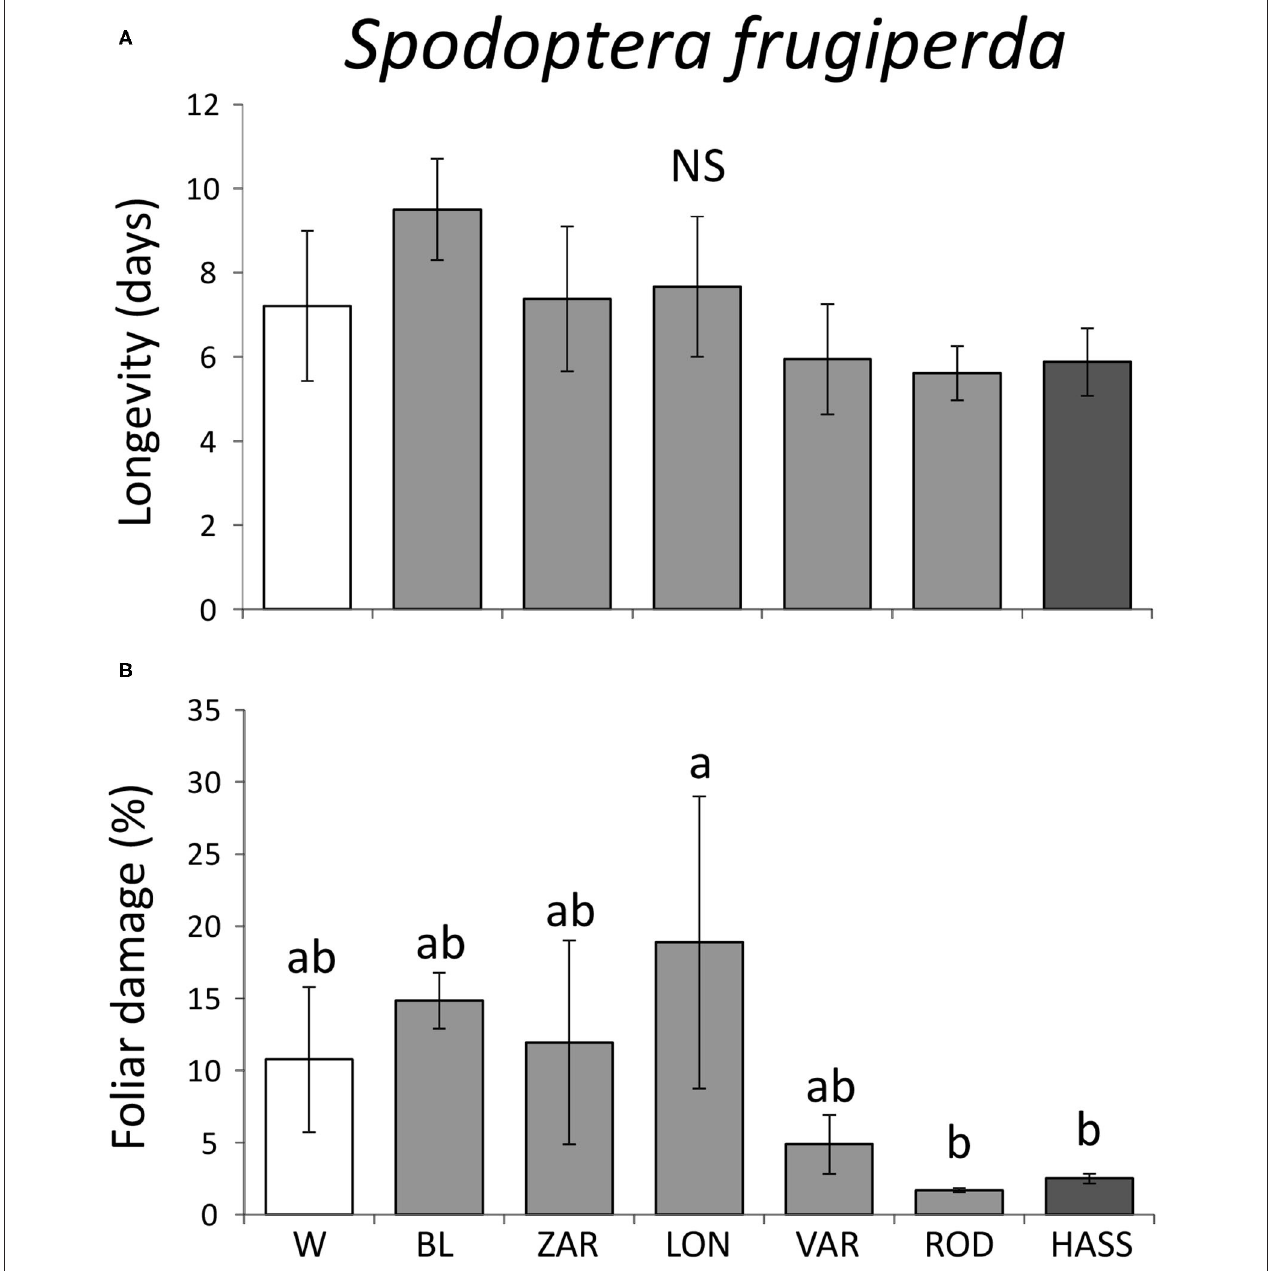
FIGURE 4 | Larval performance of the generalist fall armyworm, Spodoptera frugiperda , on wild, landrace, and cultivated “Hass” avocado ( Persea americana ) genotypes: larval longevity (A) and percent foliar damage (B) . W = wild genotypes; landraces: BL = “Blanco,” LON = “Lonjas,” ZAR = “Zarcoli,” VAR = “Vargas,” and ROD = “Rodolfo.” Bars are means ± SE. Different letters indicate significant differences among genotypes ( P ≤ 0.05), according to Tukey’s HSD post-hoc